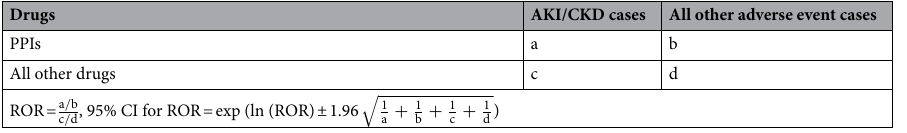
Table 5. Two-by-two contingency table for reporting odds ratio analyses. PPIs proton pump inhibitors, AKI acute kidney injury, CKD chronic kidney disease, ROR reporting odds ratio, 95% CI 95% confidence interval.